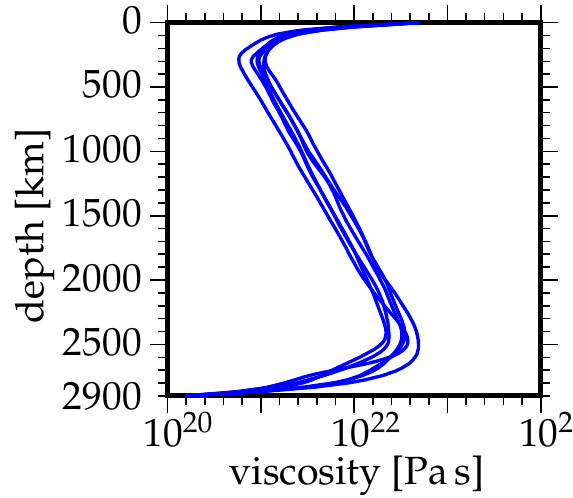
Figure 1. Plots of the typical profiles of viscosity in the radial direction. The profiles are calculated from Equation (6) together with the radial profiles of horizontally-averaged temperature for the snapshots shown in Figure